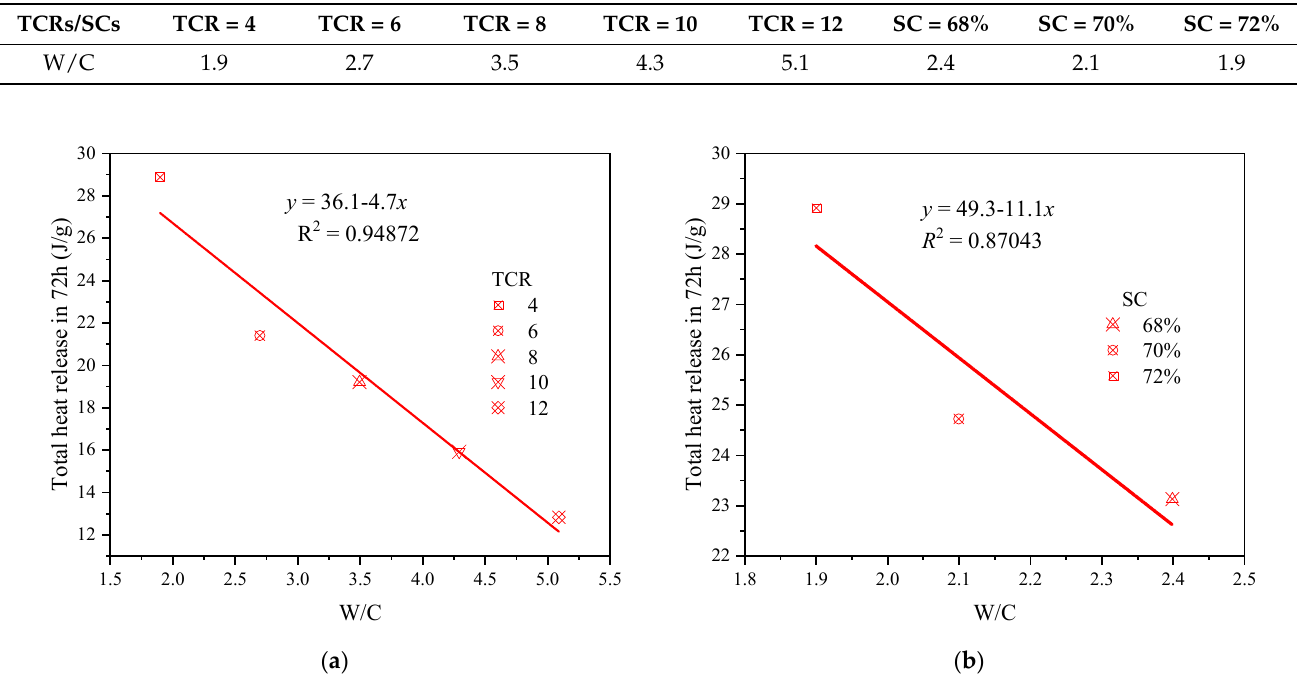
Table 6. Variation in W/C with TCR and SC under given conditions.